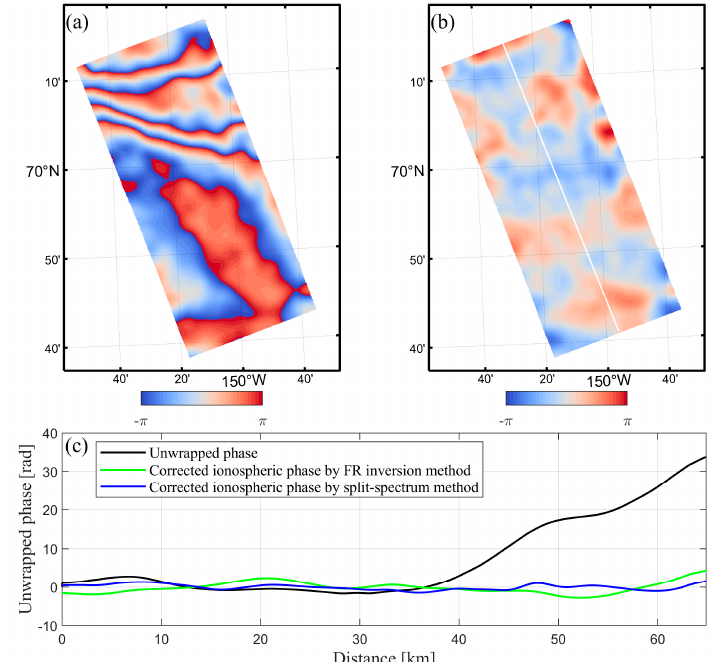
Figure 7. Ionosphere phase compensation of the Alaska case derived from the split-spectrum method: ( a ) The estimated ionospheric phase screen, and ( b ) ionosphere-compensated interferogram, ( c ) phase comparison with and without ionosphere correction along the profile in white line.